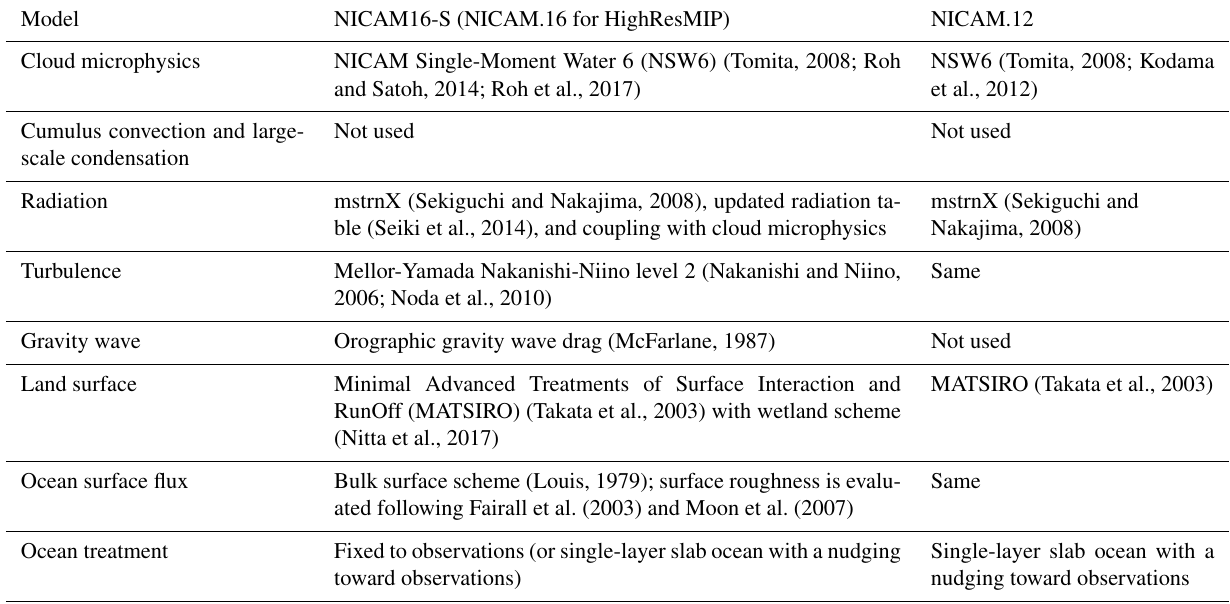
Table 4. Physics schemes in NICAM16-S and NICAM.12.